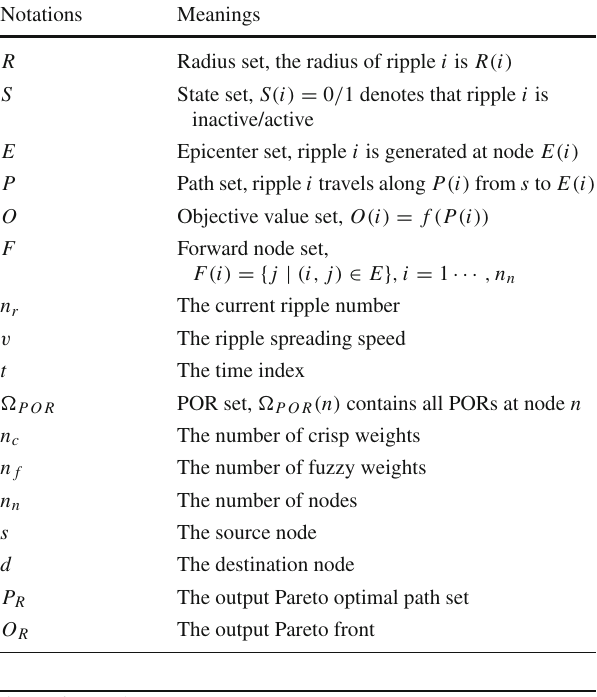
Algorithm 1 The RSA for the